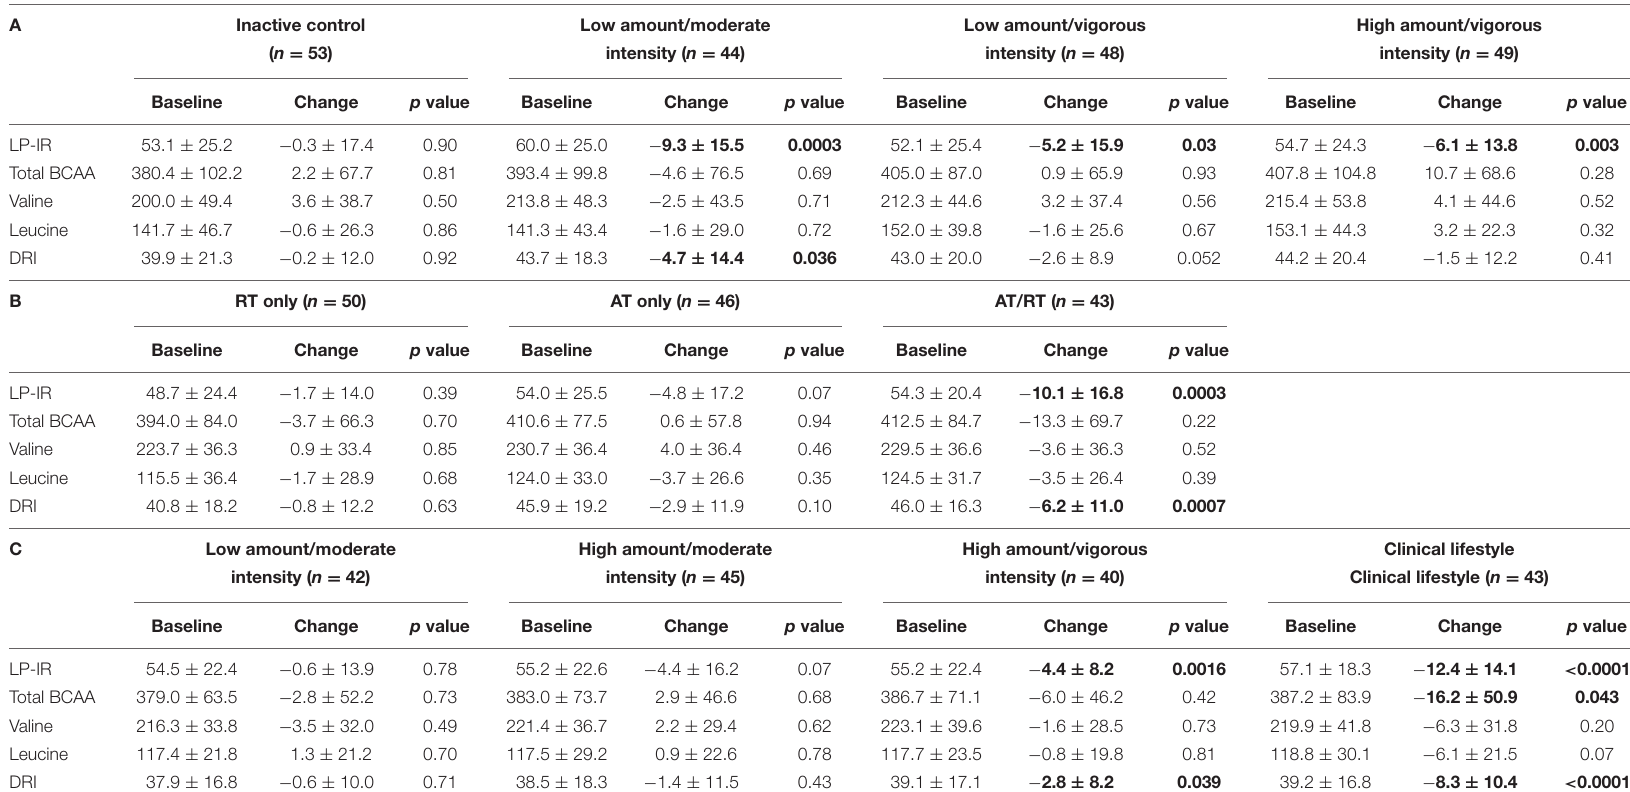
TABLE 2 | Baseline and change from baseline in LP-IR, BCAA, and Diabetes Risk Index within the various intervention groups in (A) STRRIDE I, (B) STRRIDE AT/RT, and (C)